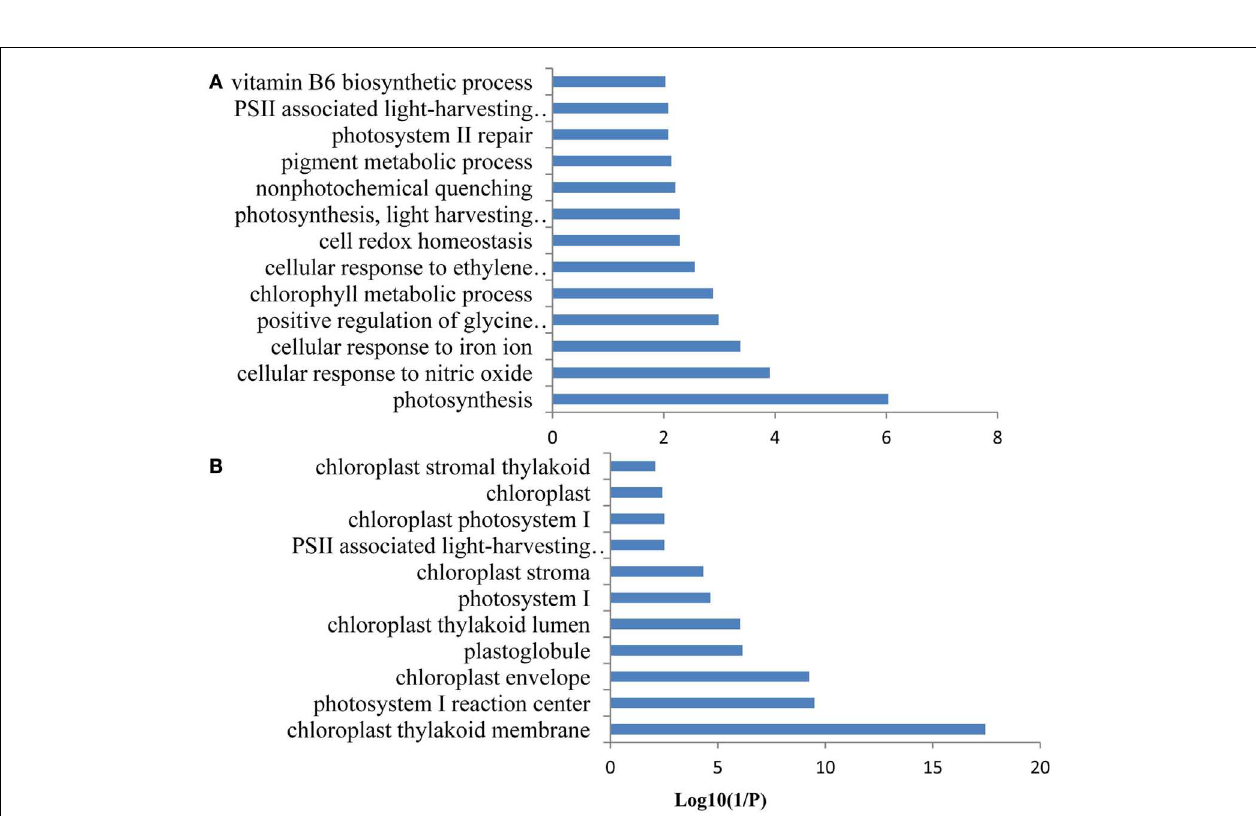
FIGURE 7 | Gene ontology (GO) enrichment analysis of the genes from FEPKPP2 . GO enrichment of the 64 Fe-responsive genes in the module FEPKPP2 was performed with the GOBU toolbox using theTopGo “elim” method with P < 0.01. (A) GO biological process and (B) GO subcellular localization.